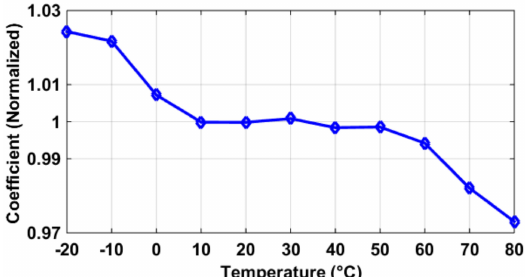
Figure 13. Measured temperature coefficient of a programmable gain amplifier (PGA)/ correlated double sampling (CDS) circuits implemented on the same CIS chip, with a PGA gain of 8, a settling time of 1 µ s, and an unity-gain bandwidth (UBW) of 10 MHz at room temperature. This PGA/CDS circuit was not used for any other measurement in this